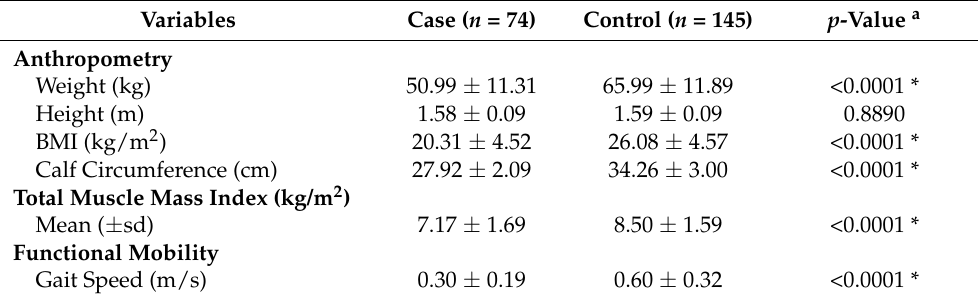
Table 2. Anthropometry, total muscle mass index, and functional mobility of the investigated